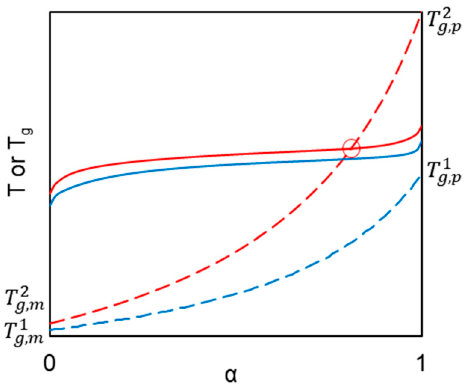
Figure 1. Schematic illustration of the effect of the polymer T g value on the reactivity of a monomer. Dashed lines represent variation of T g with conversion ( α ); solid lines represent α –T plot obtained at the heating rate β .